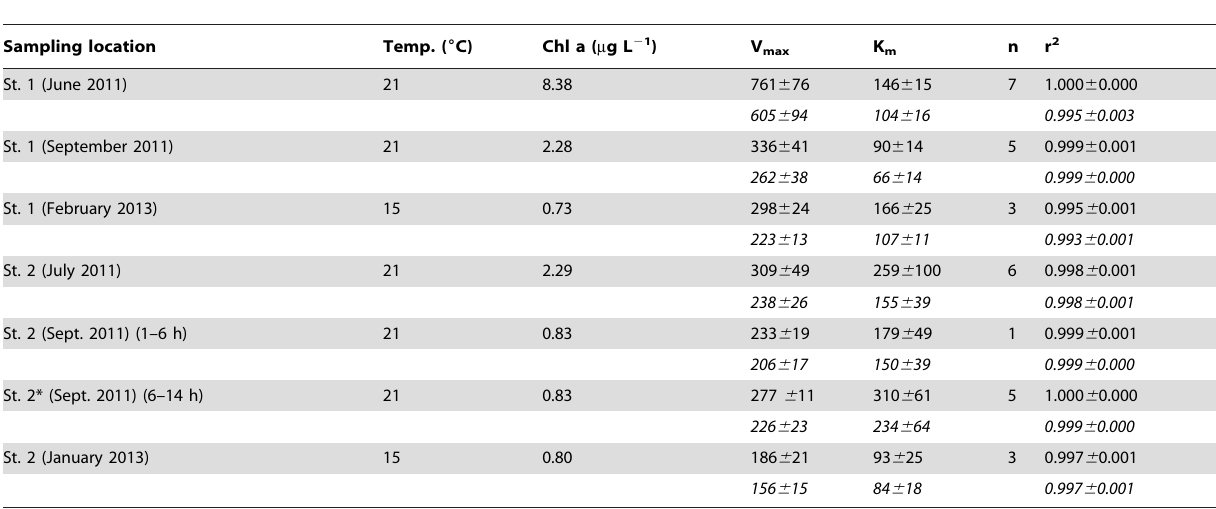
Table 1. Overview of measured community respiration rates.